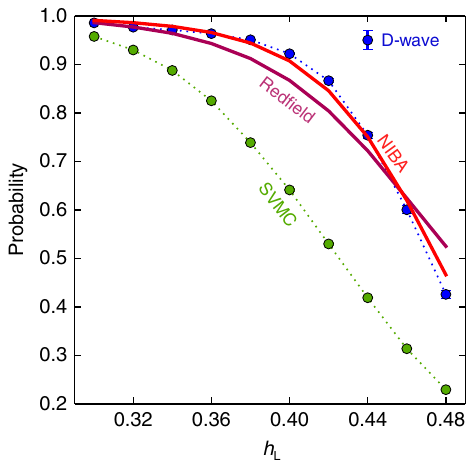
Figure 5 | Probability of success versus h L . We plot the probability of measuring the final ground state for different values of h L . The physical temperature for D-Wave is 15.(5)mK, and the annealing time is 20 m s. Both Redfield and NIBA use only measured parameters (no fitting). SVMC uses an algorithmic temperature equal to the physical temperature and 128,000 sweeps, as explained in the text. Error bars (s.e.m.) are smaller than